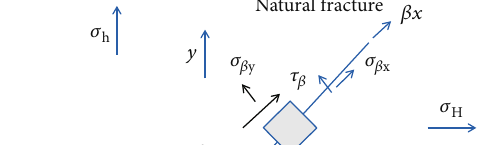
Natural fracture